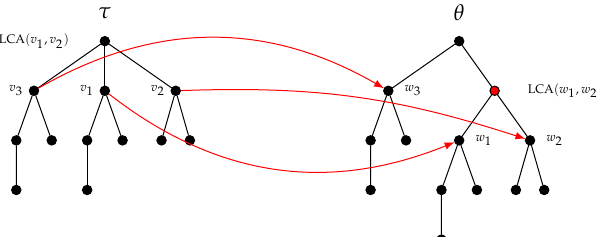
Figure 5. The tree θ is obtained from τ by inserting an internal node. The associated mapping does not satisfy the conditions imposed by Zhang [11] because the LCA (Least Common Ancestor) of v 1 and v 2 is a proper ancestor of v 3 whereas the LCA of w 1 and w 2 is not a proper ancestor of w 3 .